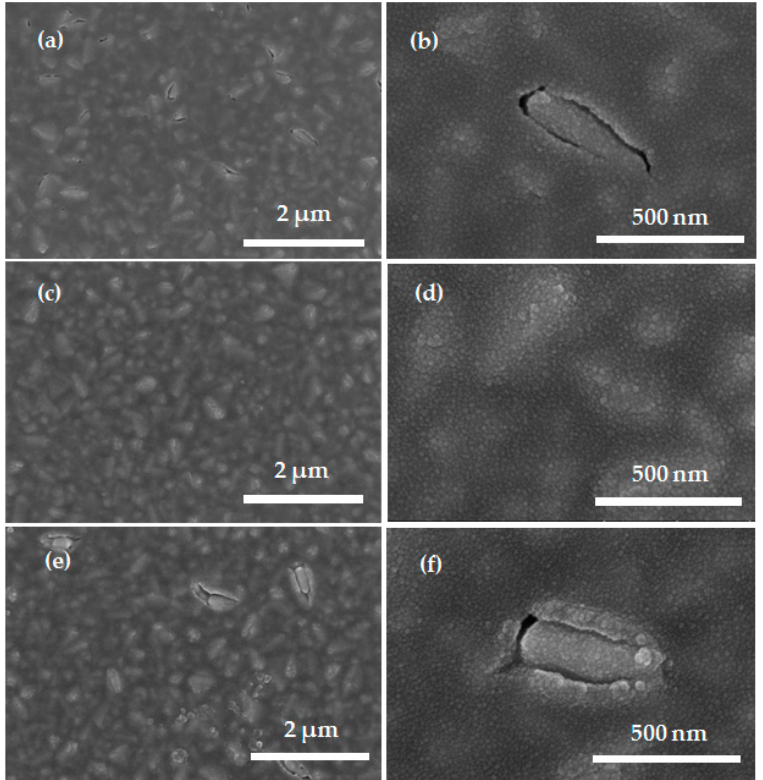
Figure 2. Top ‐ view SEM images of SnO 2 thin films deposited on compact TiO 2 ‐ coated rough FTO at different spin ‐ coating speeds for 30 s: ( a , b ) 2000 rpm; ( c , d ) 3000 rpm; ( e , f ) 4000 rpm.